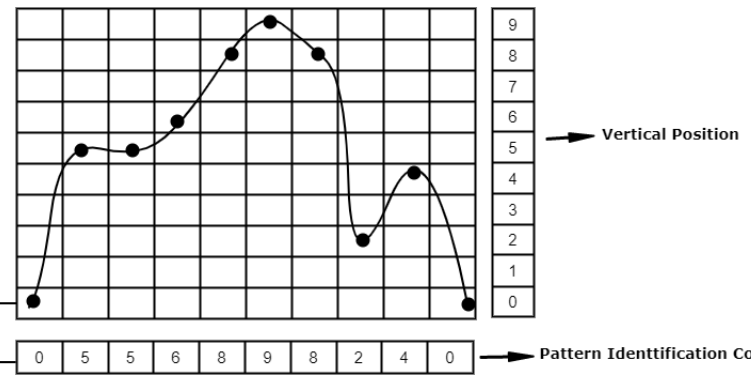
Figure 4. A time-series subsequence is represented by a 10-by-10 grid [13], which with the cell containing the data points of the sequence. The array [ 0,5,5,6,8,9,8,2, 4,0 ] is the pattern identification code (PIC) of the time series sequence, which is the data points’ vertical positions of the line during the